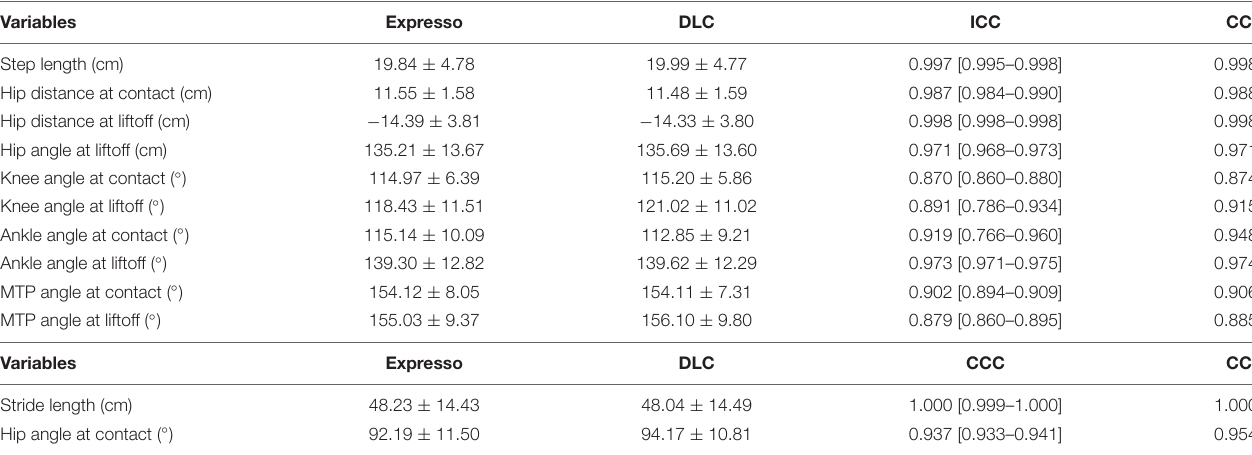
TABLE 1 | Summary of Expresso and DLC